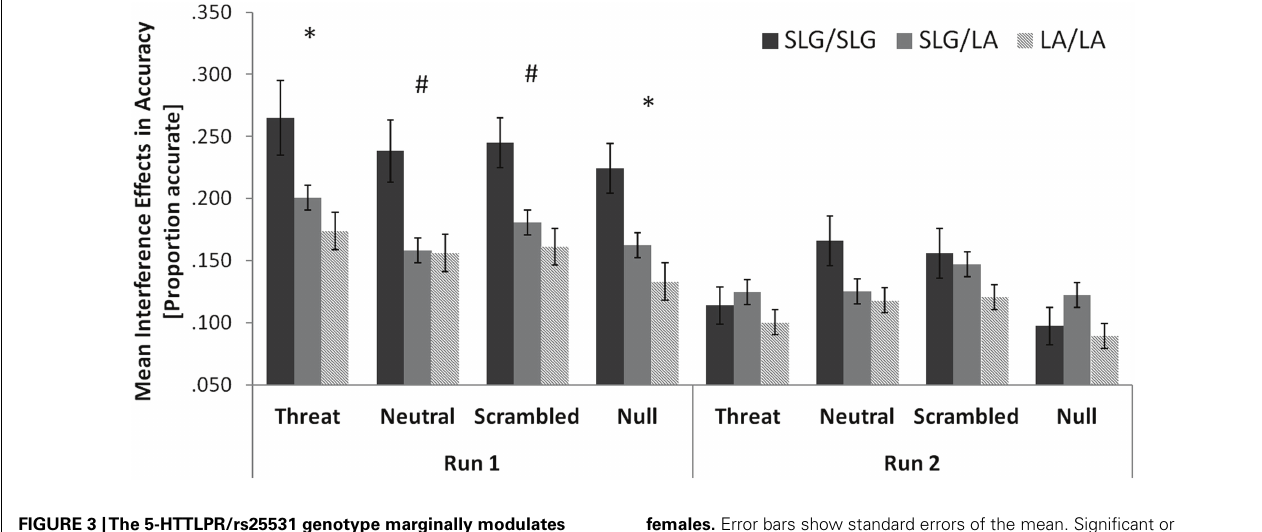
FIGURE 3 |The 5-HTTLPR/rs25531 genotype marginally modulates interference effects in accuracy across all distracter conditions in healthy